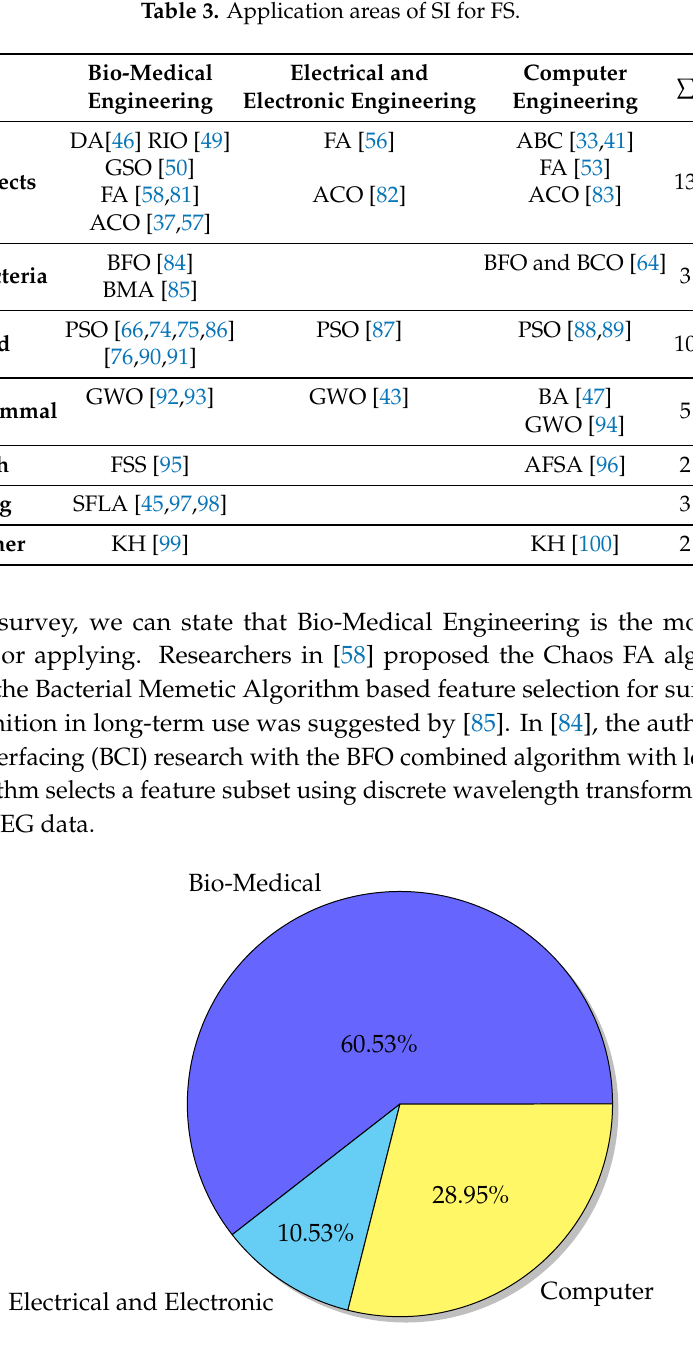
Table 3. Application areas of SI for FS.